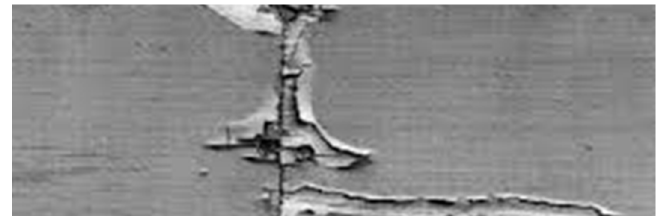
Figure 4. Coating failure due to moisture build up in end grain.